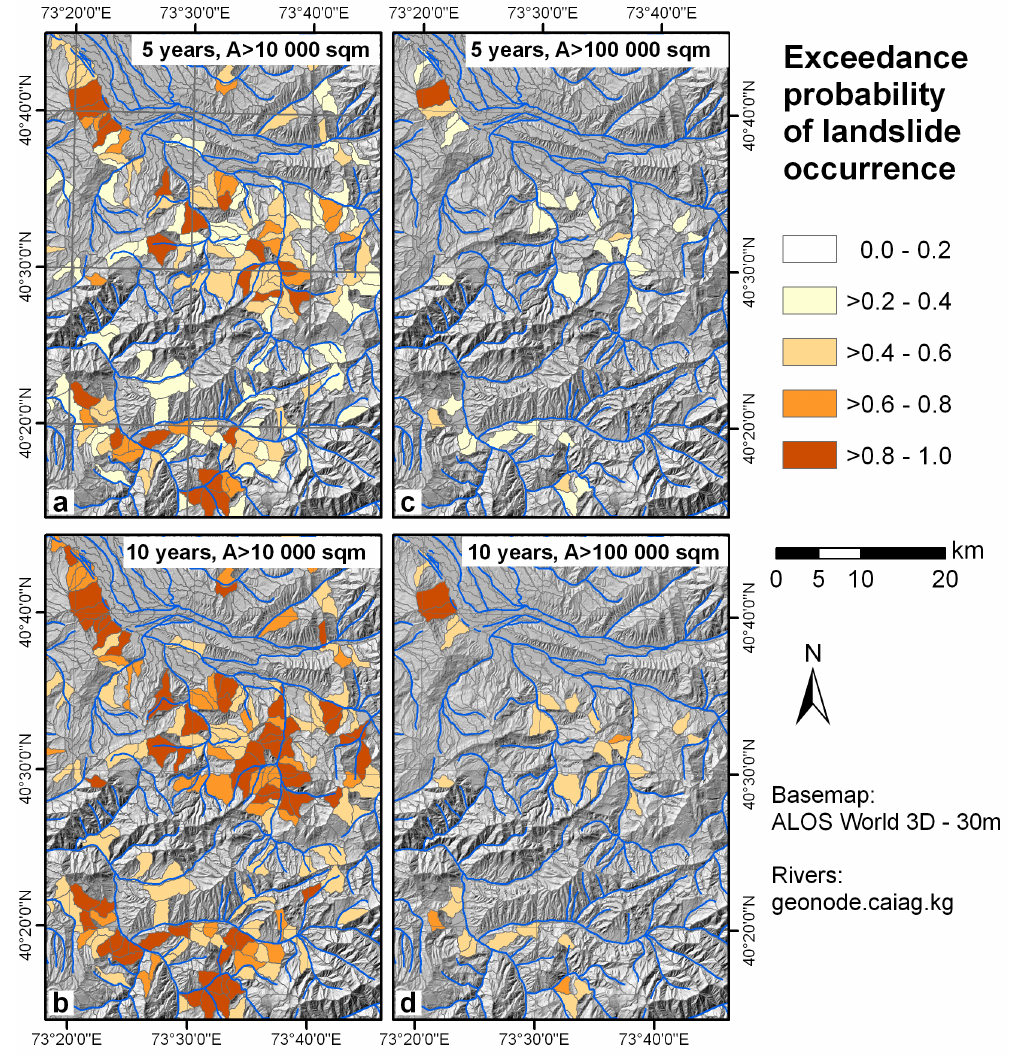
Figure 8. Exceedance probability of the occurrence of a landslide with an area over 10,000 m 2 ( a,b ) and over 100,000 m 2 ( c,d ) by slope